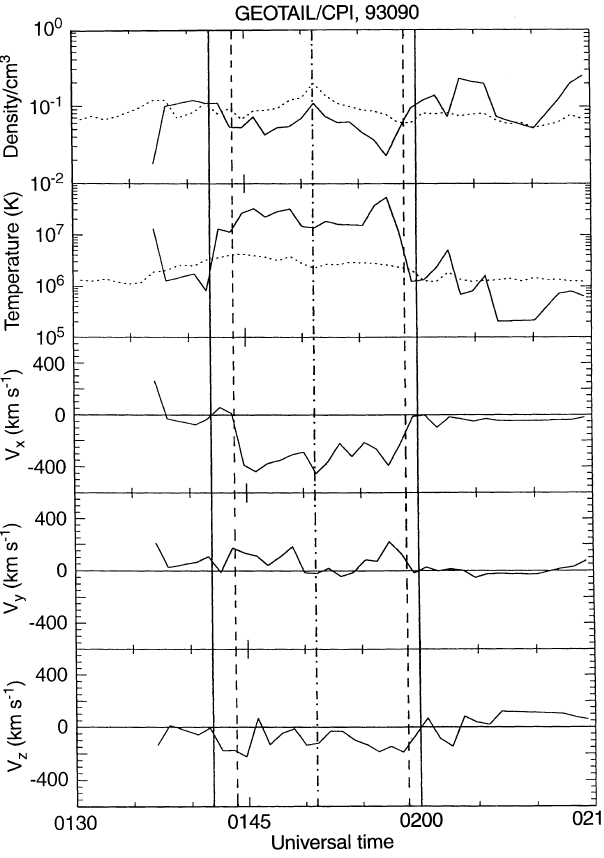
Fig. 3. The KP parameters of number densities and temperatures for protons ( solid line ) and electrons ( dashed line ) are shown in the upper two panels for the flux rope signature centred at 0147 UT on March 31, 1993. The components of proton bulk flow are shown in the lower three panels . The vertical lines are plotted as in Fig.